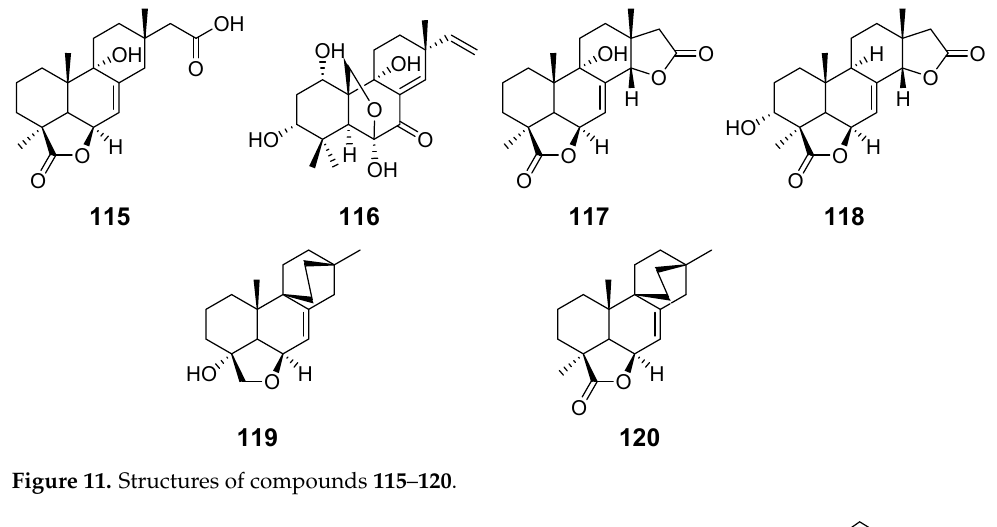
Figure 11. Structures of compounds 115 – 120 .